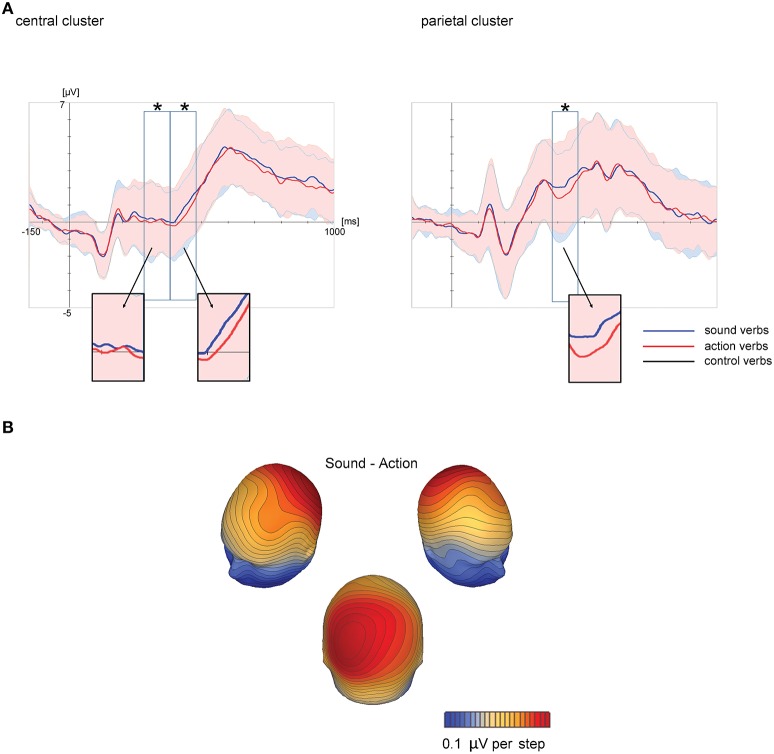
Grand-averaged ERPs at central and parietal scalp regions, averaged across electrode sites within each scalp region in Experiment 2 (A) as a function of feature type (action and sound verbs). In Experiment 2, the control verbs were omitted. Time windows analyzed statistically (180–280, 280–380, and 380–480 ms) are marked by black rectangles. Colored shadings indicate standard deviations. Significant ERP effects of feature type are highlighted by asterisks. Corresponding topographical potential maps at the time point of maximum global field power are shown for ERP differences between sound and action verbs are visualized (B).